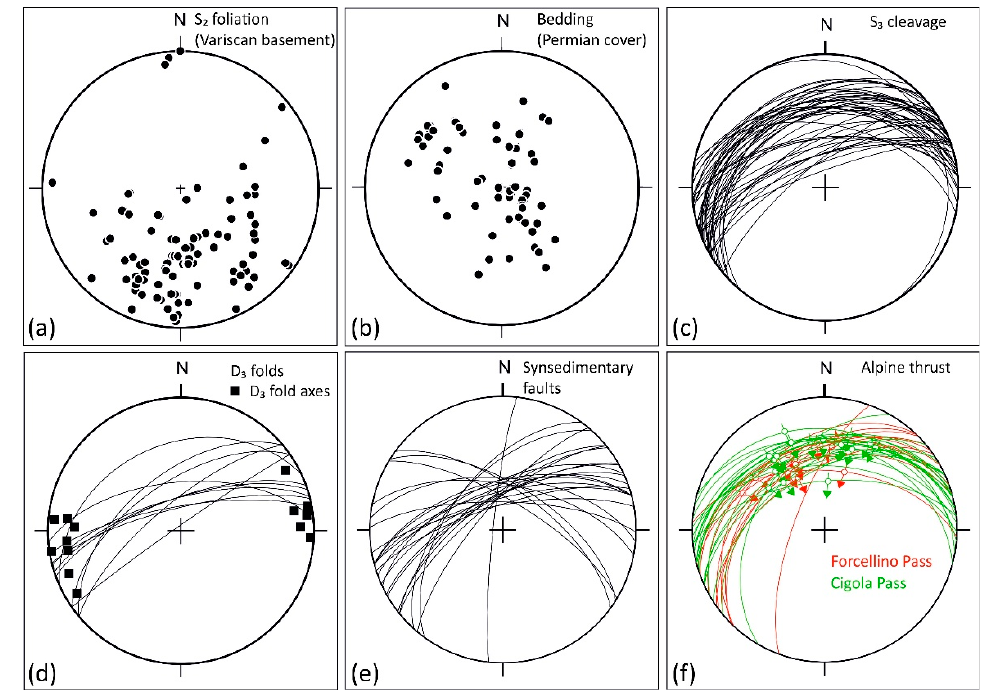
Figure 7. Stereographic projections (equal area, lower emisphere) of mesoscopic structures in the Forcellino Pass area. ( a ) Poles to planes of the main foliation (S 2 ) in the Variscan basement. ( b ) Poles to bedding planes in the Pizzo del Diavolo Fm. ( c ) S 3 axial plane cleavage of Alpine age in the hanging wall of the LANF. ( d ) Axial planes and fold hinges of D 3 folds, measured both in the crystalline basement and in the Permian cover. ( e ) Syn-sedimentary normal faults. ( f ) Fault slip data related to Alpine thrust at the Forcellino and Cigola passes.